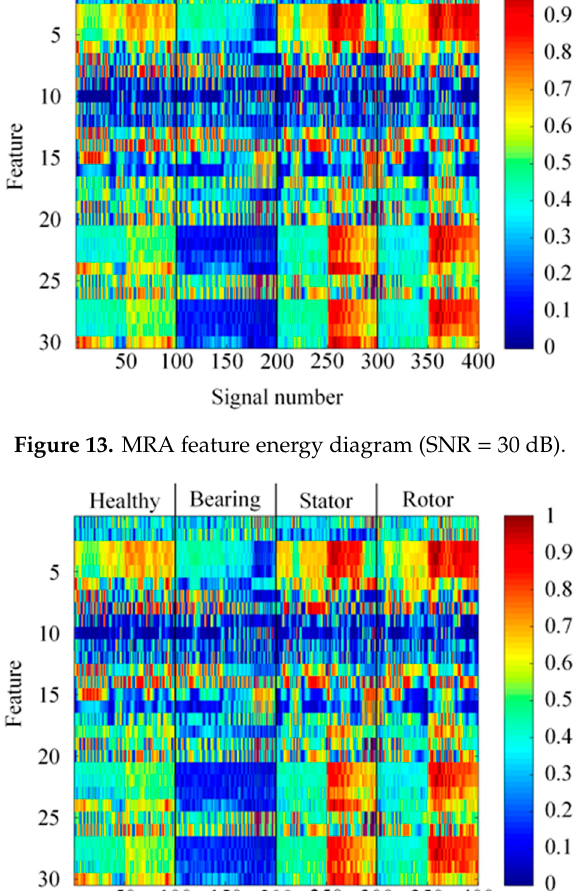
Figure 14. MRA feature energy diagram (SNR = 25 dB).